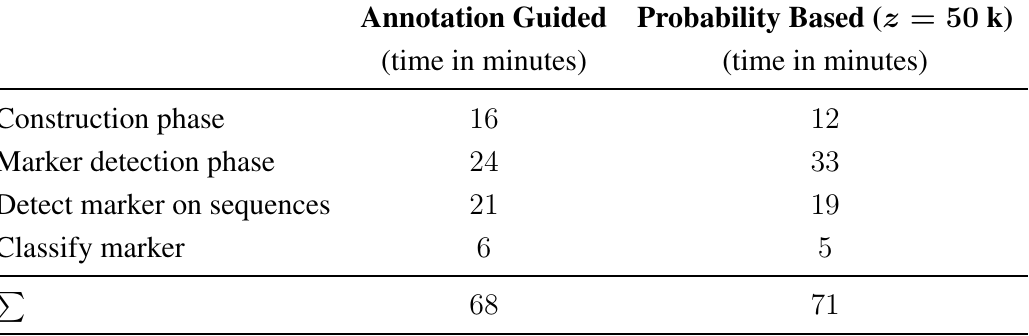
Table 1. Runtime of one exemplary